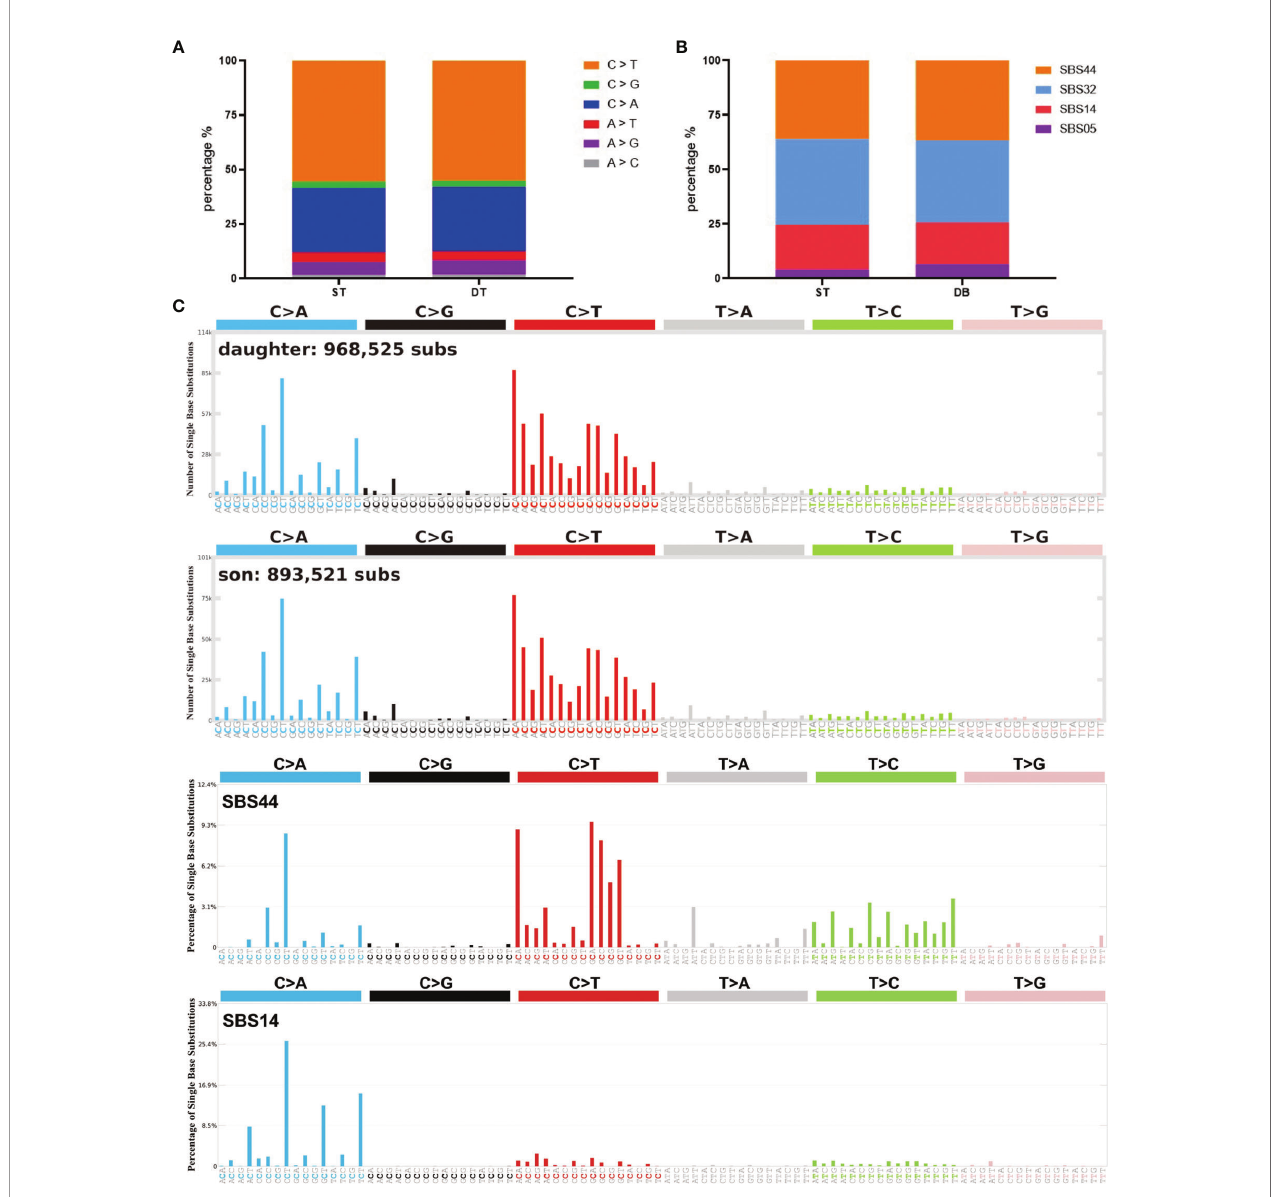
FIGURE 3 | Summary of SBS signatures of the two brain tumor cases. (A) The distribution of different single base substitution types. (B, C) SBS signatures of the two brain tumor cases and two comparable mutational signatures: SBS44 and